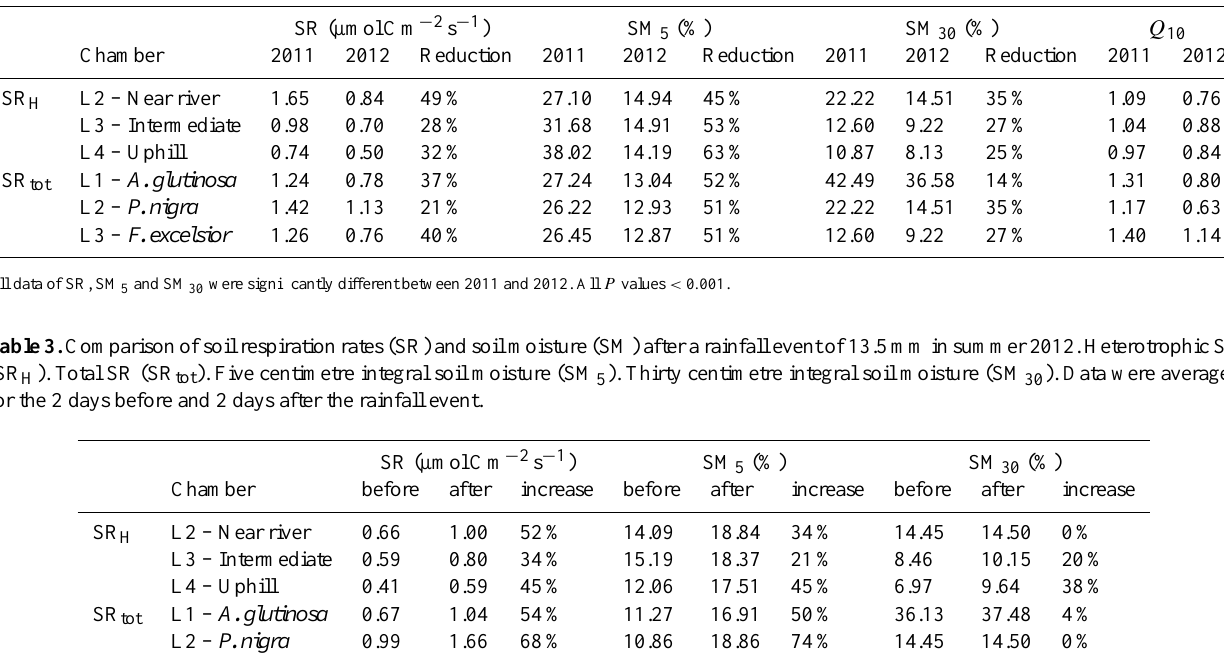
Table 2. Comparison of soil respiration rates (SR), soil moisture (SM) and Q 10 values in 2011 and 2012 summer campaigns. Heterotrophic SR (SR H ). Total SR (SR tot ). Five centimetre integral soil moisture (SM 5 ). Thirty centimetre integral soil moisture (SM 30 ).